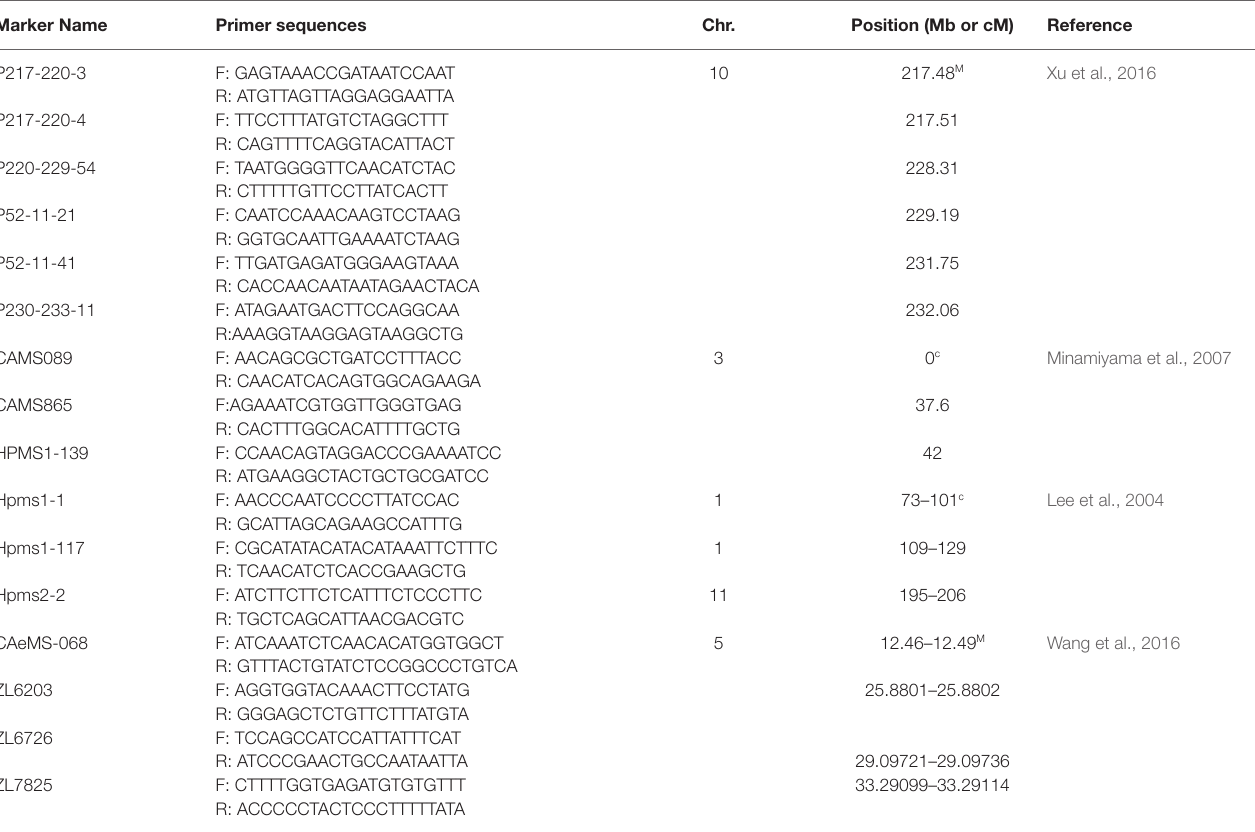
TABLE 2 | Simple sequence repeat markers for conversion to allele-specific KASP assays and validation using for marker-assisted breeding of Phytophthora capsici